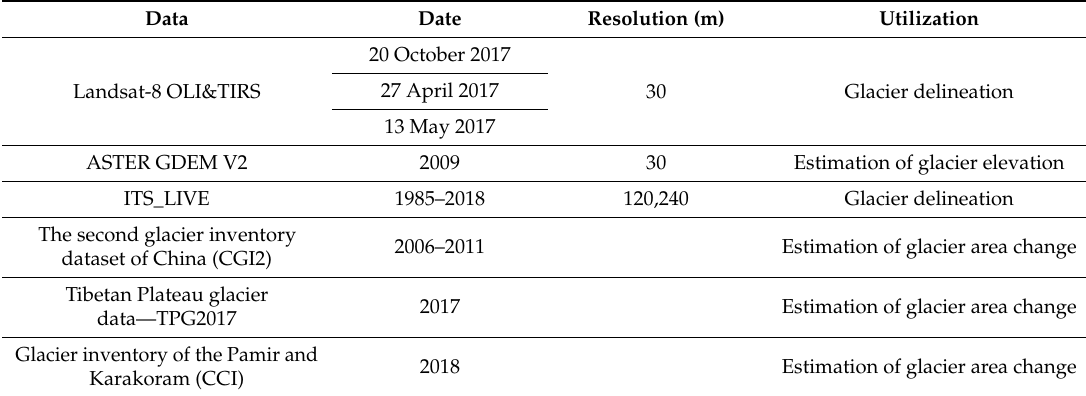
Table 2. List of datasets used in this